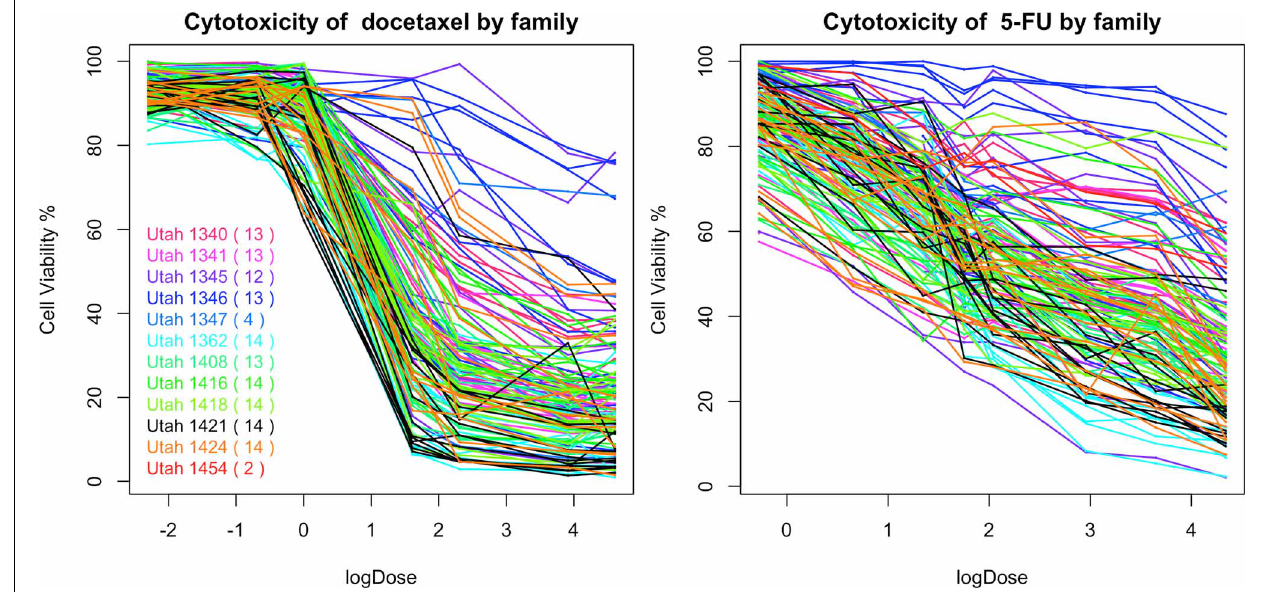
FIGURE 10 | The cytotoxicity responses of docetaxel and 5-FU.